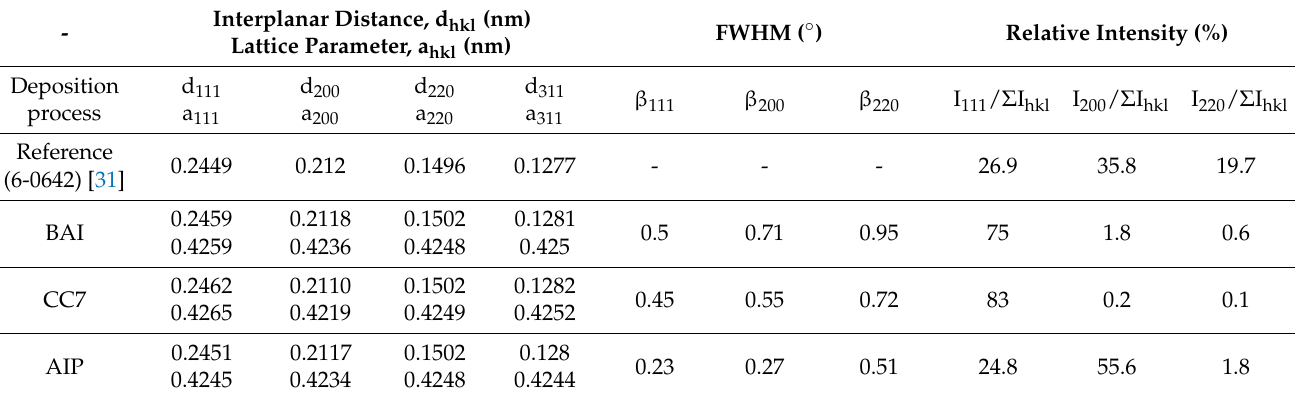
Table 2. Results of X-ray diffraction analysis of TiN coatings deposited by three different deposition methods: low-voltage electron beam evaporation (BAI), unbalanced magnetron sputtering (CC7) and cathodic arc deposition